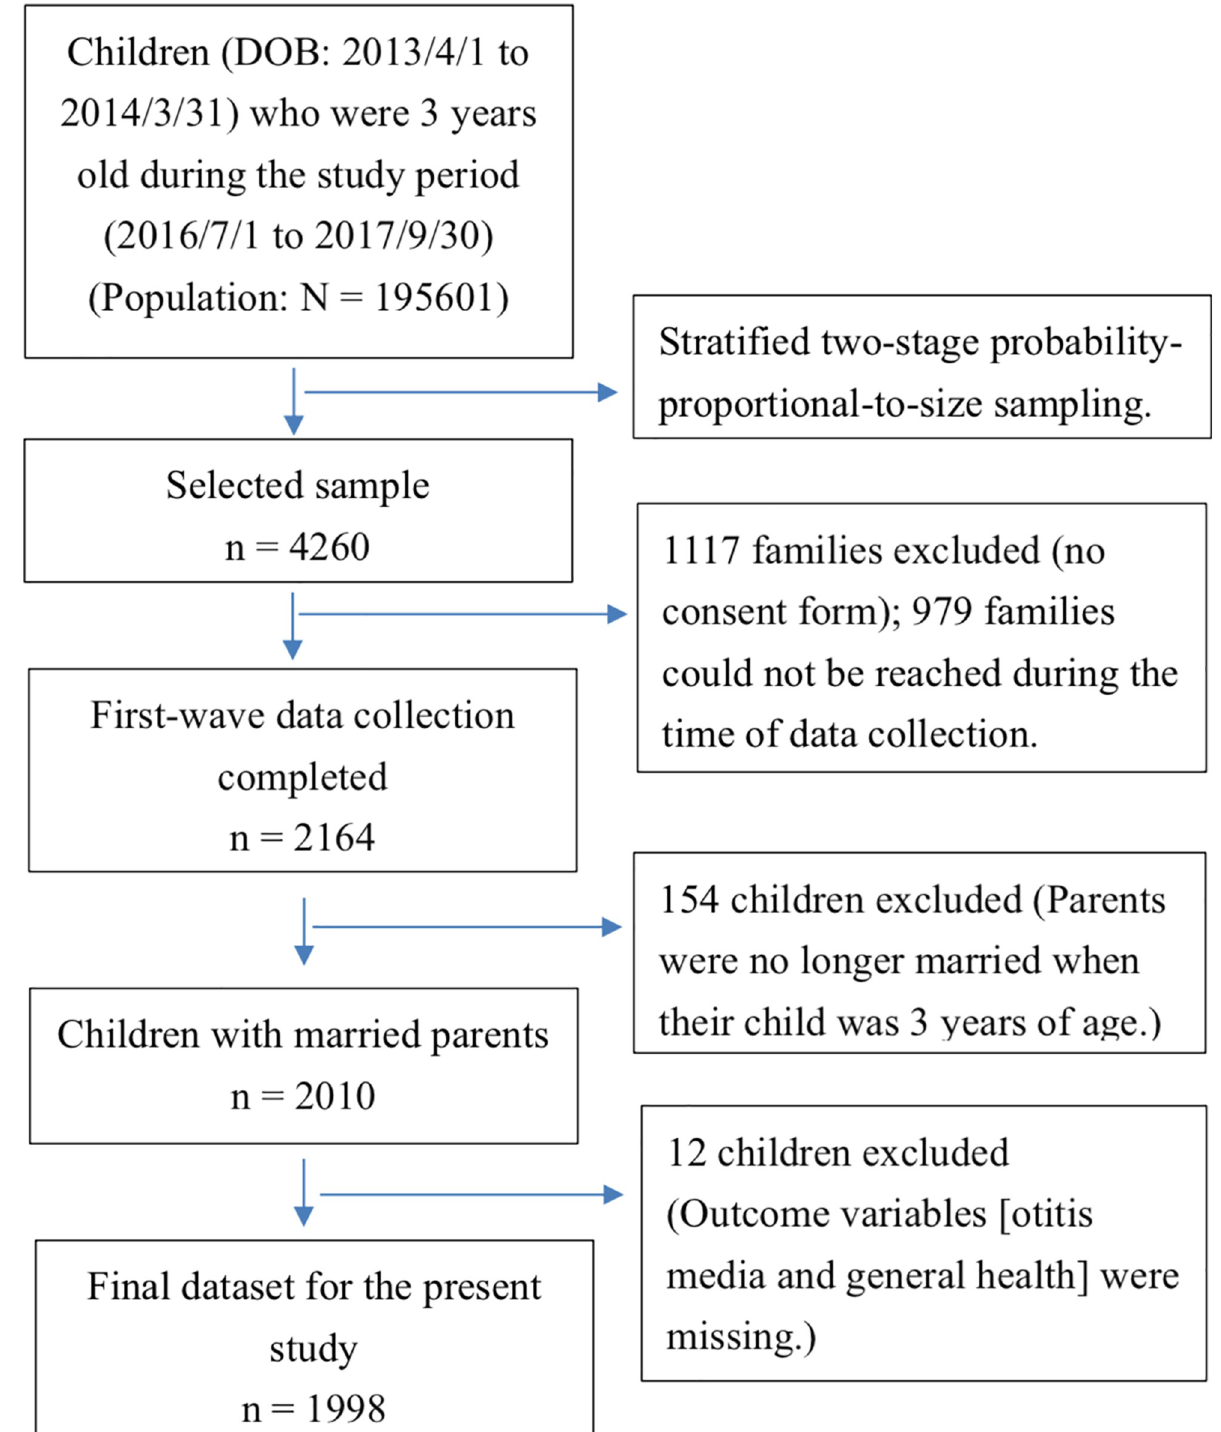
Fig 1. Flowchart of participant